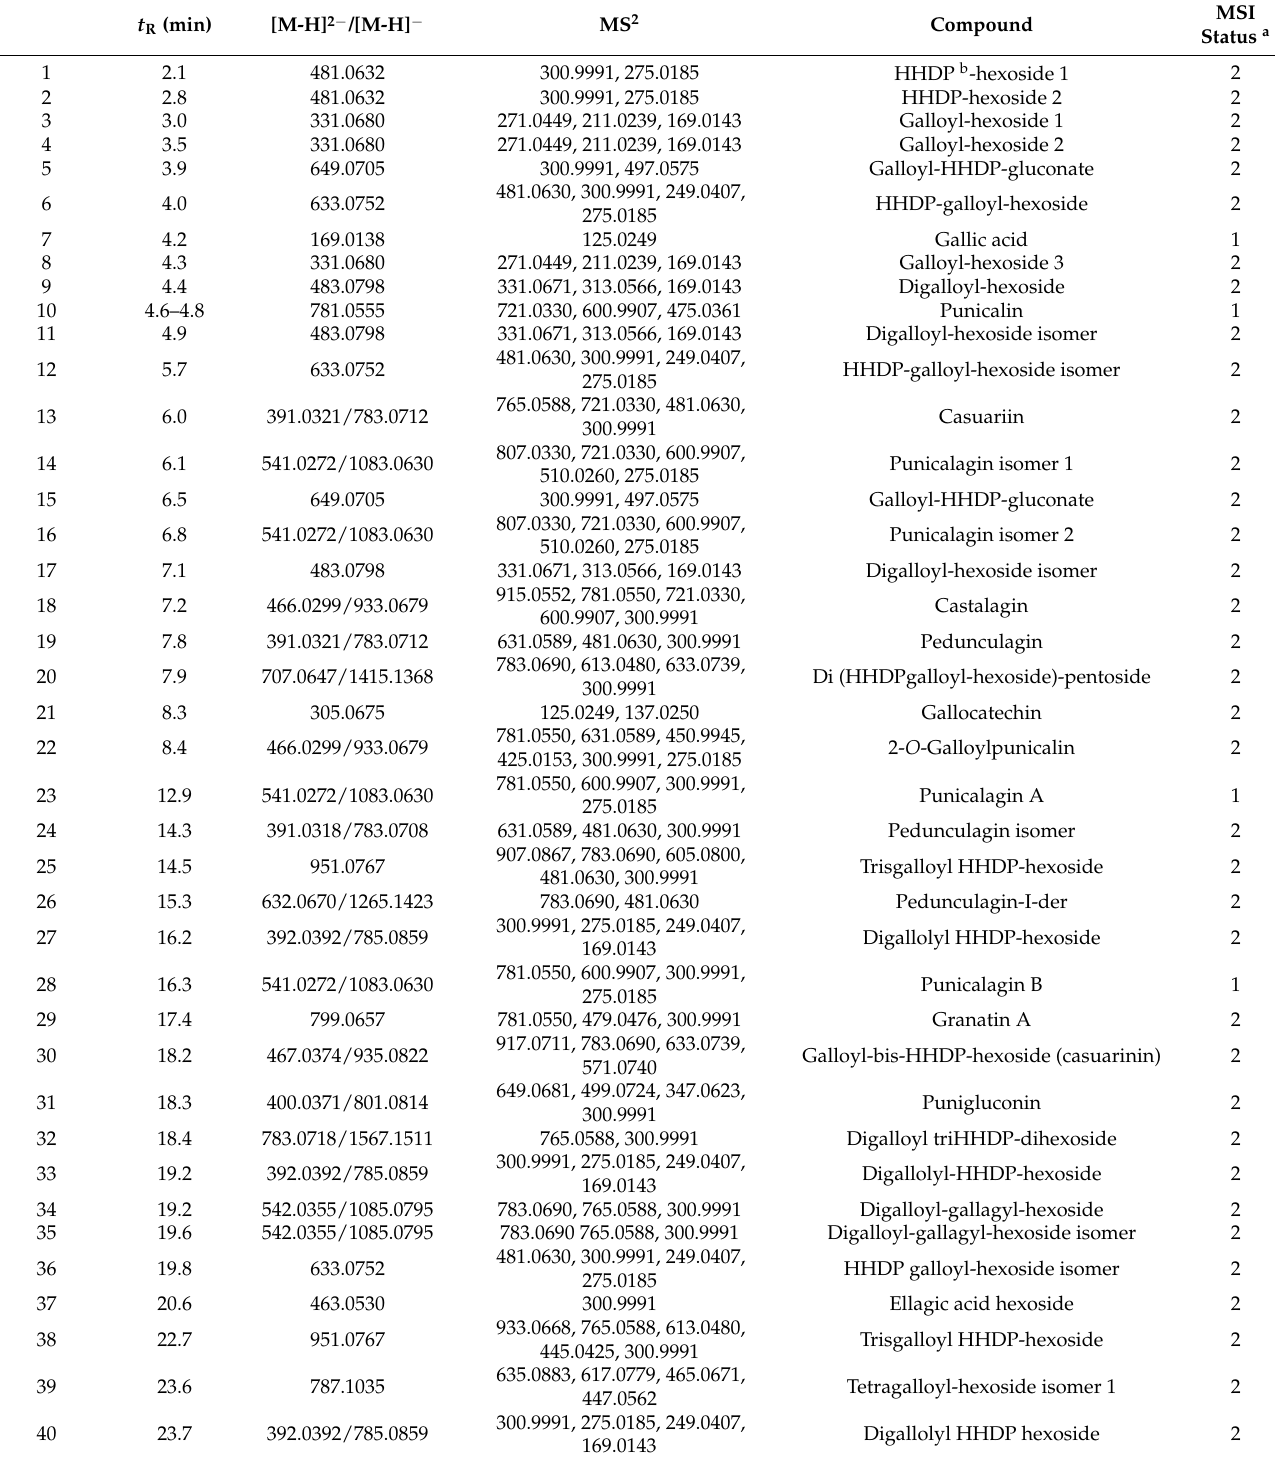
Table 2. UHPLC-HR-ESI-MS/MS data of compounds detected in pomegranate peels